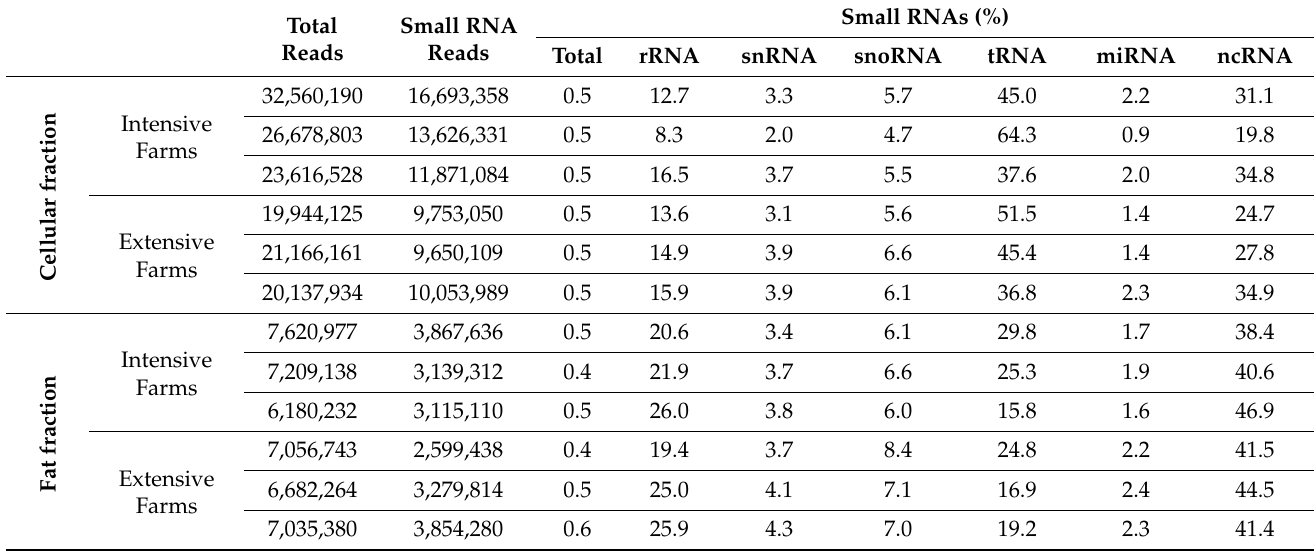
Table 3. Read mapping statistics.